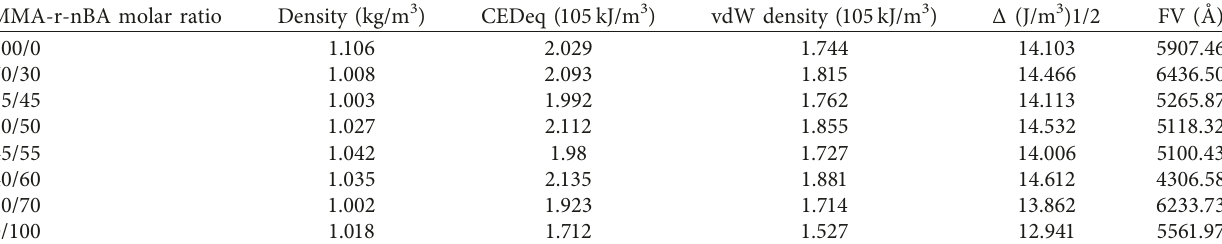
Figure 5: MD simulation results as a function of poly(MMA-r-nBA) copolymer composition. Trend of van der Waals Force (vdWeq) (curve (a) as well as the density ( ρ ) (curve (b) as a function of poly(MMA-r-nBA) copolymers with different molar ratios. Table 2: Cohesive energy density of equilibrated (CEDeq), van der Waals (vdW) density, free volume (FV), density ( ρ ), and solubility parameter ( δ ) as a function of MMA-r-nBA molar